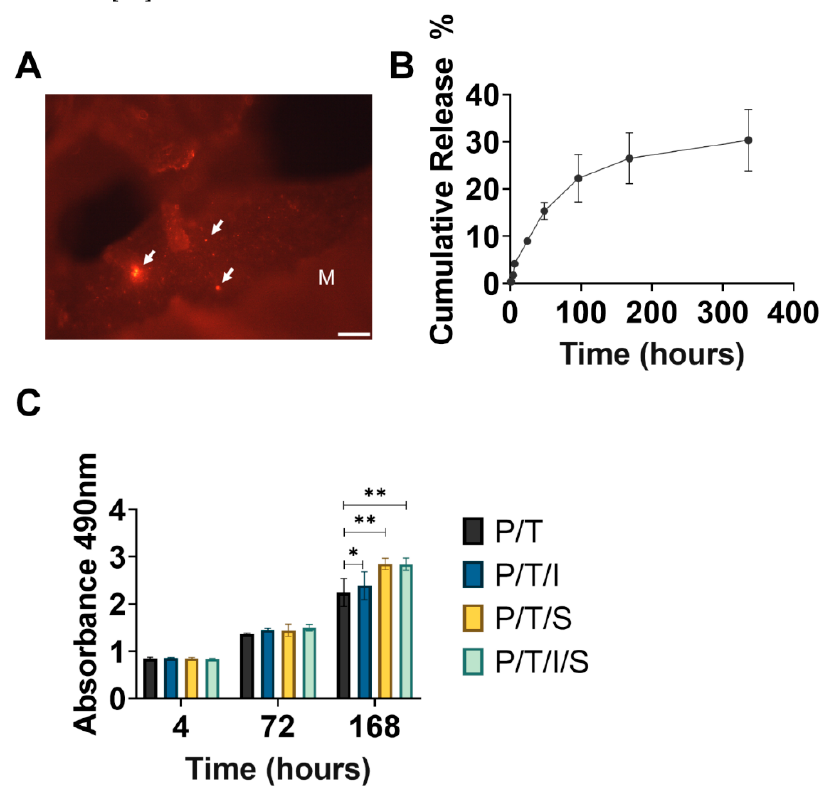
Figure 3. Loading and release of HFS in the P/T-based scaffolds. ( A ) P/T/I scaffold incorporating HFS (466.7 ± 9.4 µ g protein per cylinder). White arrows indicate PKH26-stained extracellular vesicles of HFS, scale bar = 20 µ m, M:material. ( B ) Kinetics of HFS released from the P/T/I/S scaffold in vitro. ( C ) Cell proliferation. Data are shown as mean ± SD (* p < 0.05, ** p < 0.01, one-way ANOVA with Tukey’s HSD, n = 3).